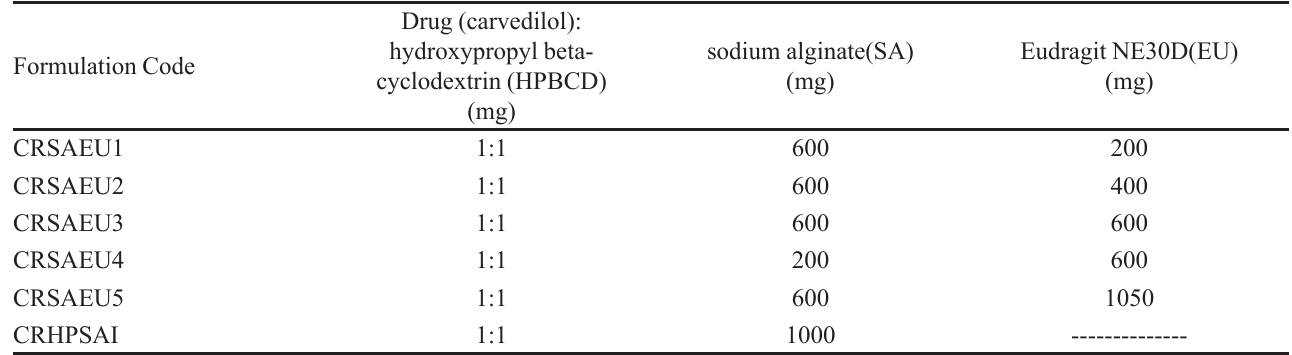
TABLE I - Composition of formulations